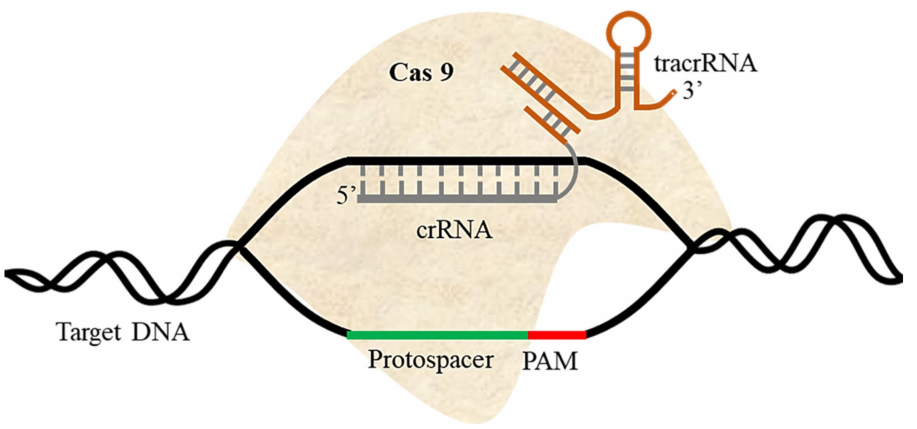
Figure 2. Schematic diagram of CRISPR/Cas9. This system utilizes Cas9 enzyme and two RNAs: crRNA and tracrRNA. On binding with target DNA at the PAM site, it creates DSBs with blunt